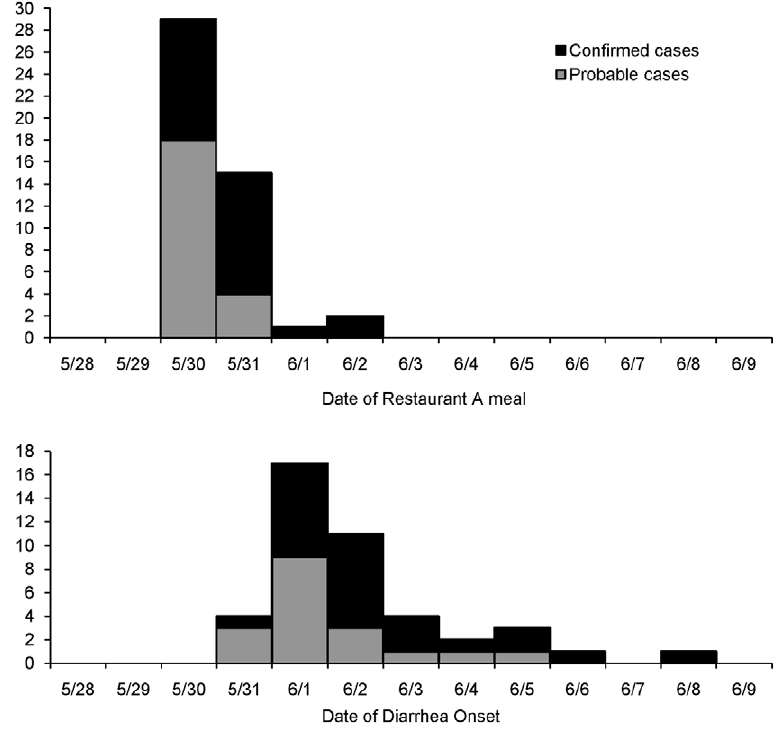
Figure 1. Restaurant A-associated cases by date of meal (top) and diarrhea onset (bottom). Black bars represent 25 confirmed cases. Grey bars represent 22 probable cases. The exact dates of diarrhea onset are not available for 4 probable cases. doi:10.1371/journal.pone.0016579.g001 PLoS ONE |